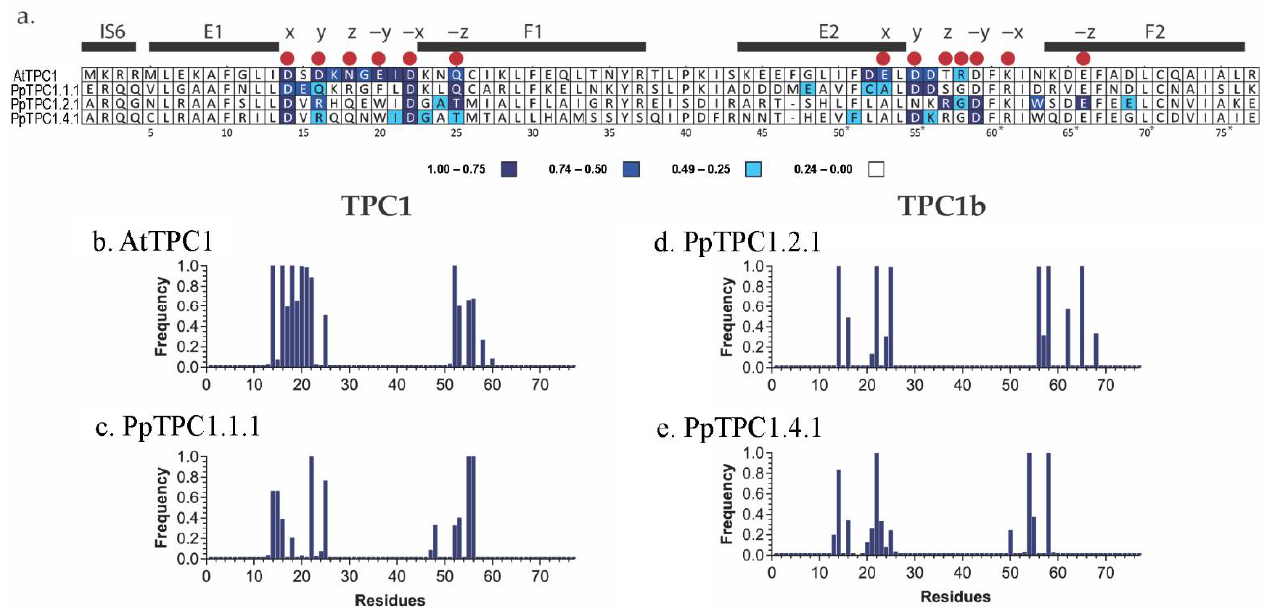
Figure 6. Relative frequencies of the interaction of the residues with Ca 2+ . Calculating the interaction frequencies with Ca 2+ in molecular dynamics simulations for each model was performed with a cutoff of 5 Å to calcium. The frequencies were estimated from a total of 1500 ns of molecular dynamics, corresponding to the last 500 ns, with three replicates per model. ( a ) Alignment of amino acid sequences per model; the blue color shows the frequency of interaction of each residue with the Ca 2+ ion within at a distance of up to 5 Å. The higher the frequency, the higher the probability of being part of the Ca 2+ -binding site. Alpha helices are represented by black bars, and residues reported as part of the calcium-binding site in the AtTPC1 crystal structure are represented by red dots. The numbering corresponds to the consecutive numbering used in the models. Please note the gap at position 47 of the alignment of PpTPC1.2.1 and PpTPC1.4.1. To cope with this gap, for values ≥ 47, one position needs to be subtracted for these two channels (indicated by an asterisk *). ( b – e ) Relative interaction frequency of the residues with Ca 2+ : ( b ) AtTPC1 and ( c ) PpTPC1.1.1 correspond to the EF-hand models of the TPC1 type channels, and ( d ) PpTPC1.2.1 and ( e ) PpTPC1.4.1 correspond